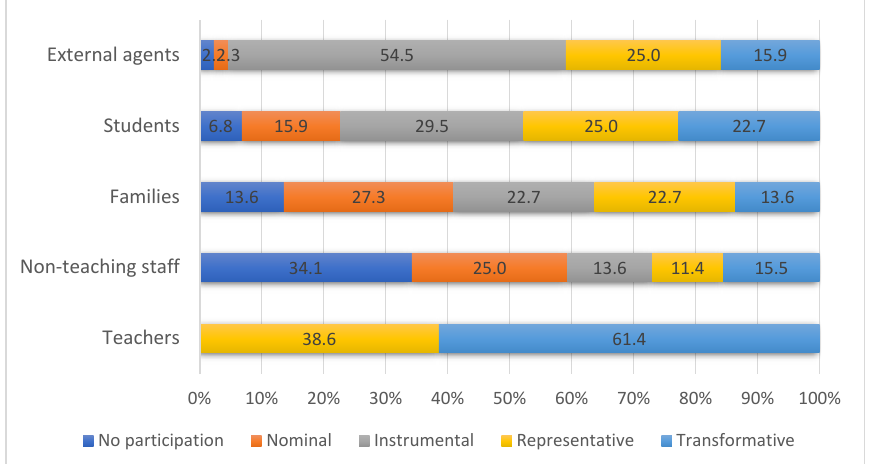
Figure 2. Educational community participation [14] in the CEPS Program.